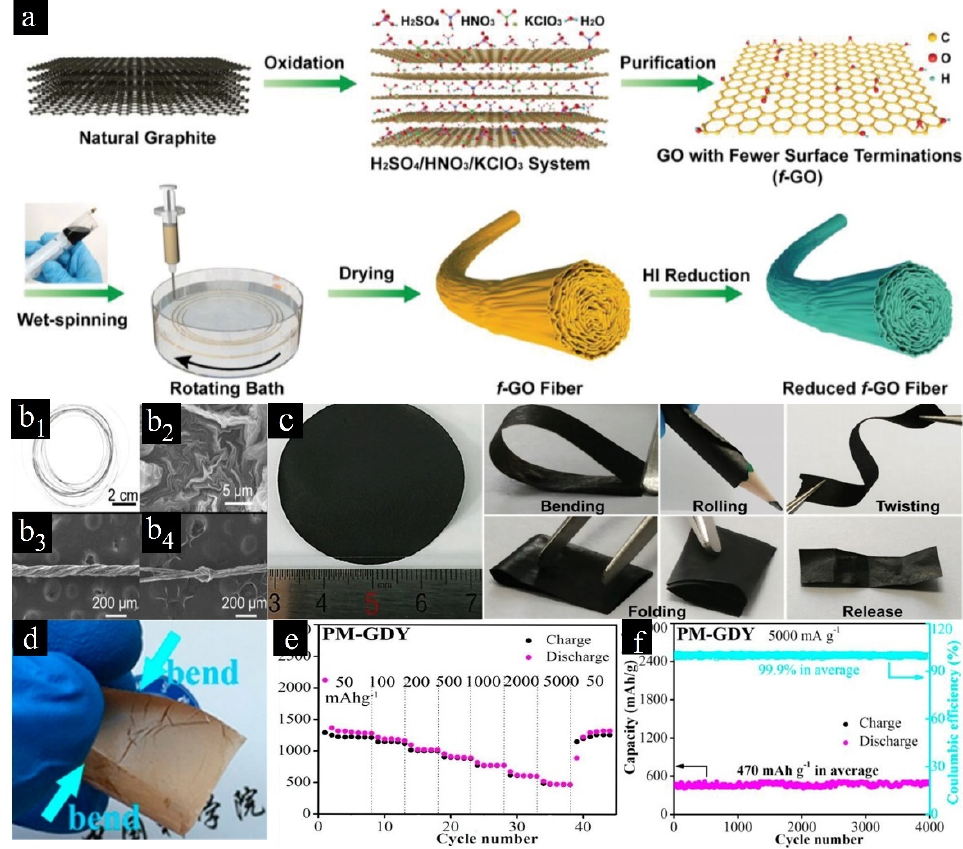
Figure 3. ( a ) Schematic of f-GO, (reduced)-GO fiber. Morphology and structure of f-GO fibers: ( b 1 ) Image of a 5 m fiber; SEM images of ( b 2 ) the fiber cross-section; ( b 3 ) twisted fibers and ( b 4 ) a tied fiber knot. ( a , b ) Reprinted with permission from [30]. Copyright John Wiley Publisher, 2022. ( c ) The appearance and flexibility exhibition images of the composite Fe 1 − x S@PCNWs/rGO film. Reprinted with permission from [32]. Copyright John Wiley and Sons Publisher, 2019. ( d ) Image of the bending pyridine-GDY film. ( e ) Rate capacity and ( f ) Cycling performances of pyrimidine-GDY. ( d – f ) Reprinted with permission from [36]. Copyright American Chemical Society Publisher, 2019.